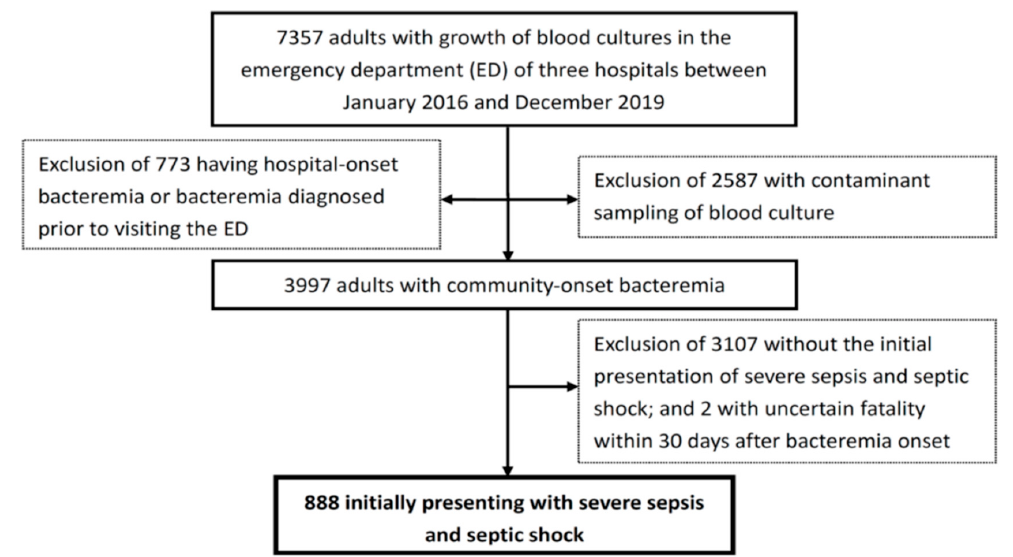
Figure 1. Flowchart of patient selection .